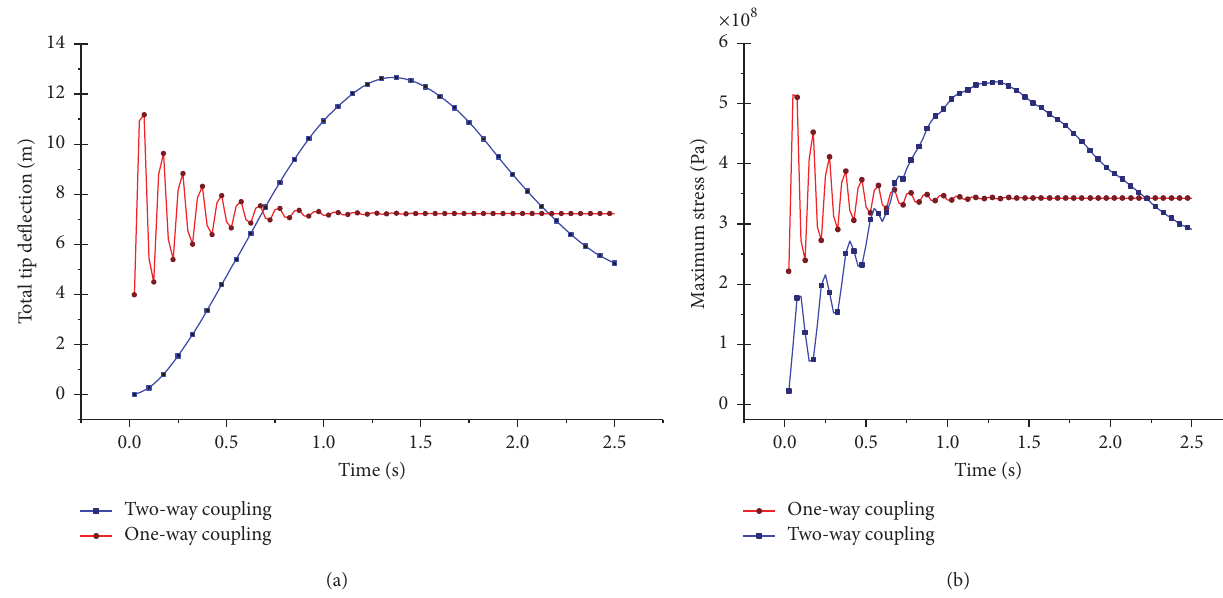
Figure 11: Blade tip deflection (a) and maximum equivalent stress (b) for half cycle of operation.